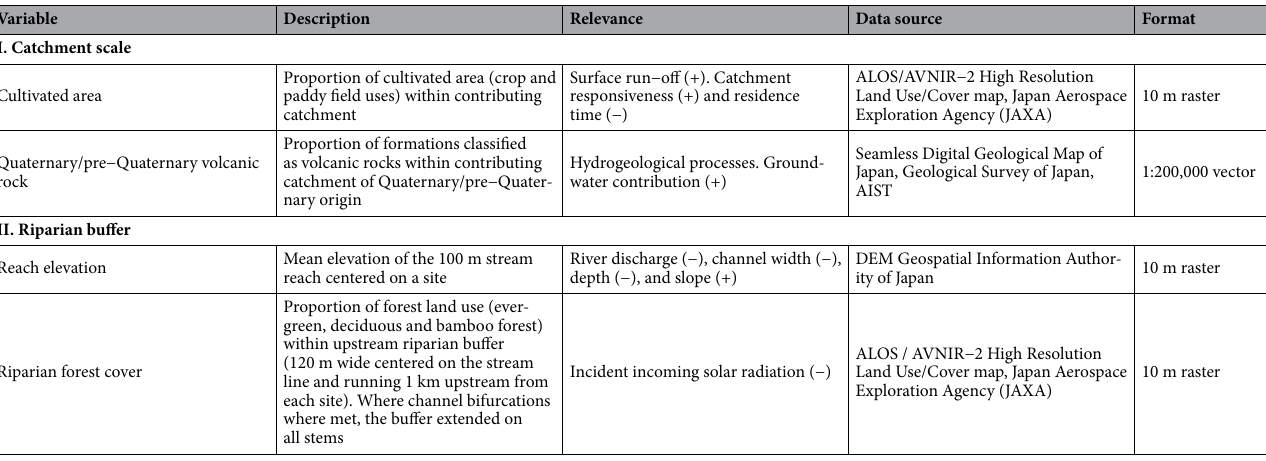
Table 1. Description of catchment- and reach-scale environmental covariates measured at each monitored site including related hydrological and stream heat exchange processes (+ /− symbols indicate expected positive/ negative relationships), and the source and format of the data sets used in this study to derive each